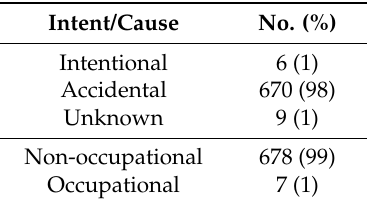
Table 4. Distribution of events in childhood reported by cause.